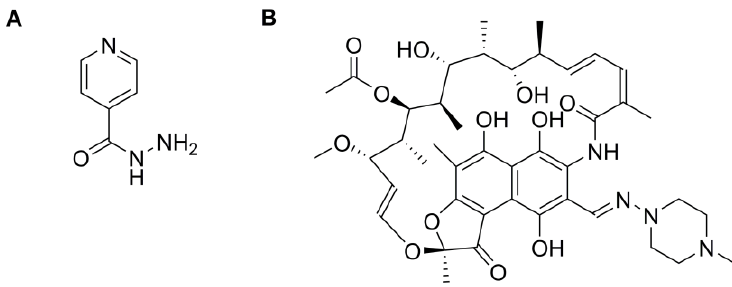
Figure 8. Chemical structures of ( A ) isoniazid and ( B ) rifampicin.